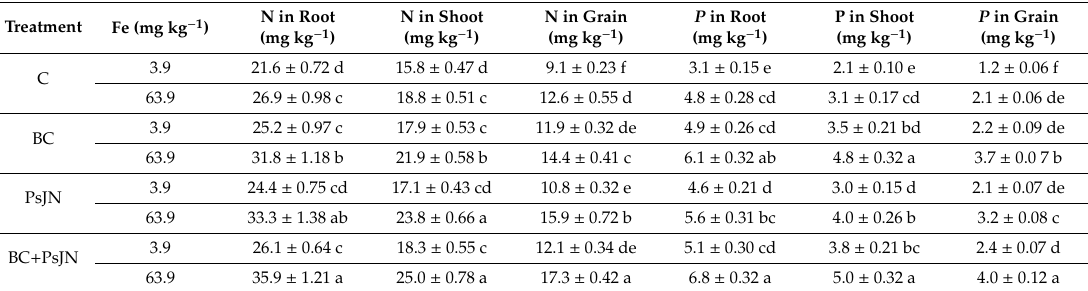
Figure 1. The e ff ect of biochar- Burkholderia phytofirmans PsJN integration on Fe concentration of Chenopodium quinoa under salinity stress. Quantities sharing similar letters are not di ff erent with each other. C: Control; BC: Biochar (1% w / w ); PsJN: Burkholderia phytofirmans ; Fe: Ferrous sulphate (15 kg ha − 1 ). Values are mean of three repeats ± SD. Table 3. The e ff ect of biochar- Burkholderia phytofirmans PsJN integration on chemical parameters (N and P ) of Chenopodium quinoa under salinity